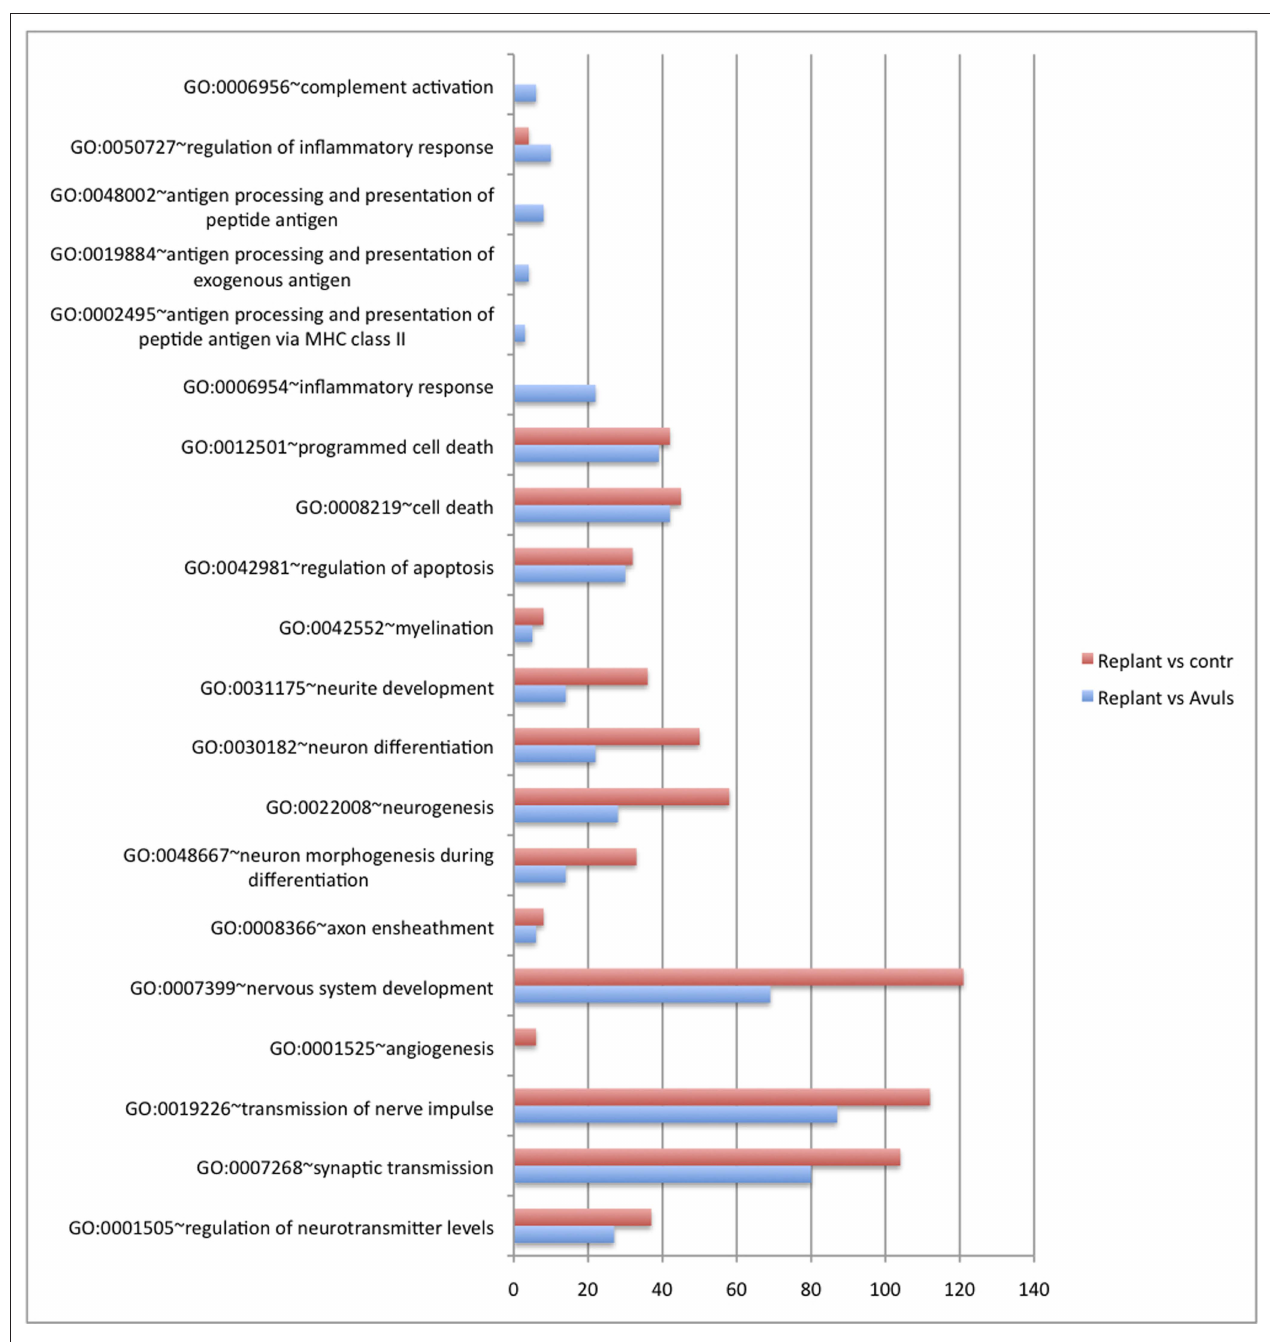
regulated genes. The number of cell death genes is similar in the two groups, while genes related to neurite development and neurogenesis show a much more prominent response after replantation than after avulsion only. The inflammatory response is more obvious after avulsion than after